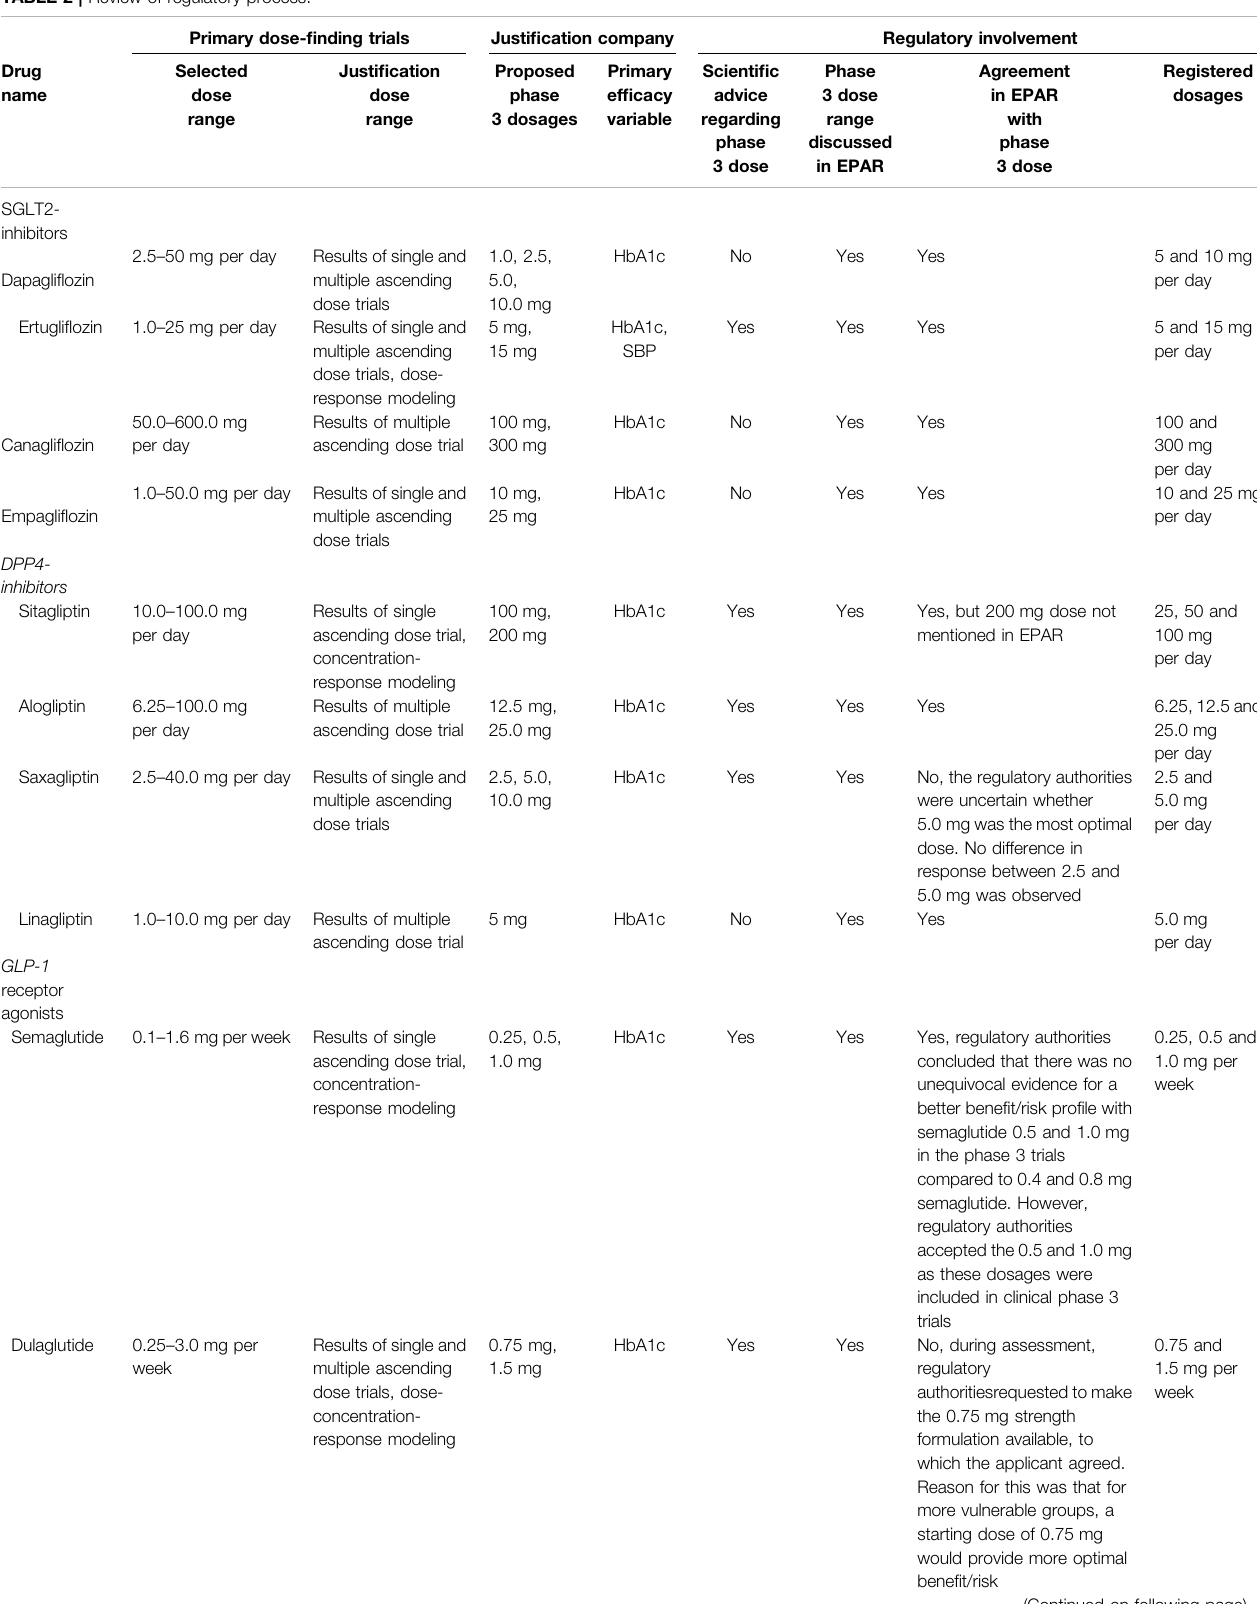
TABLE 2 | Review of regulatory